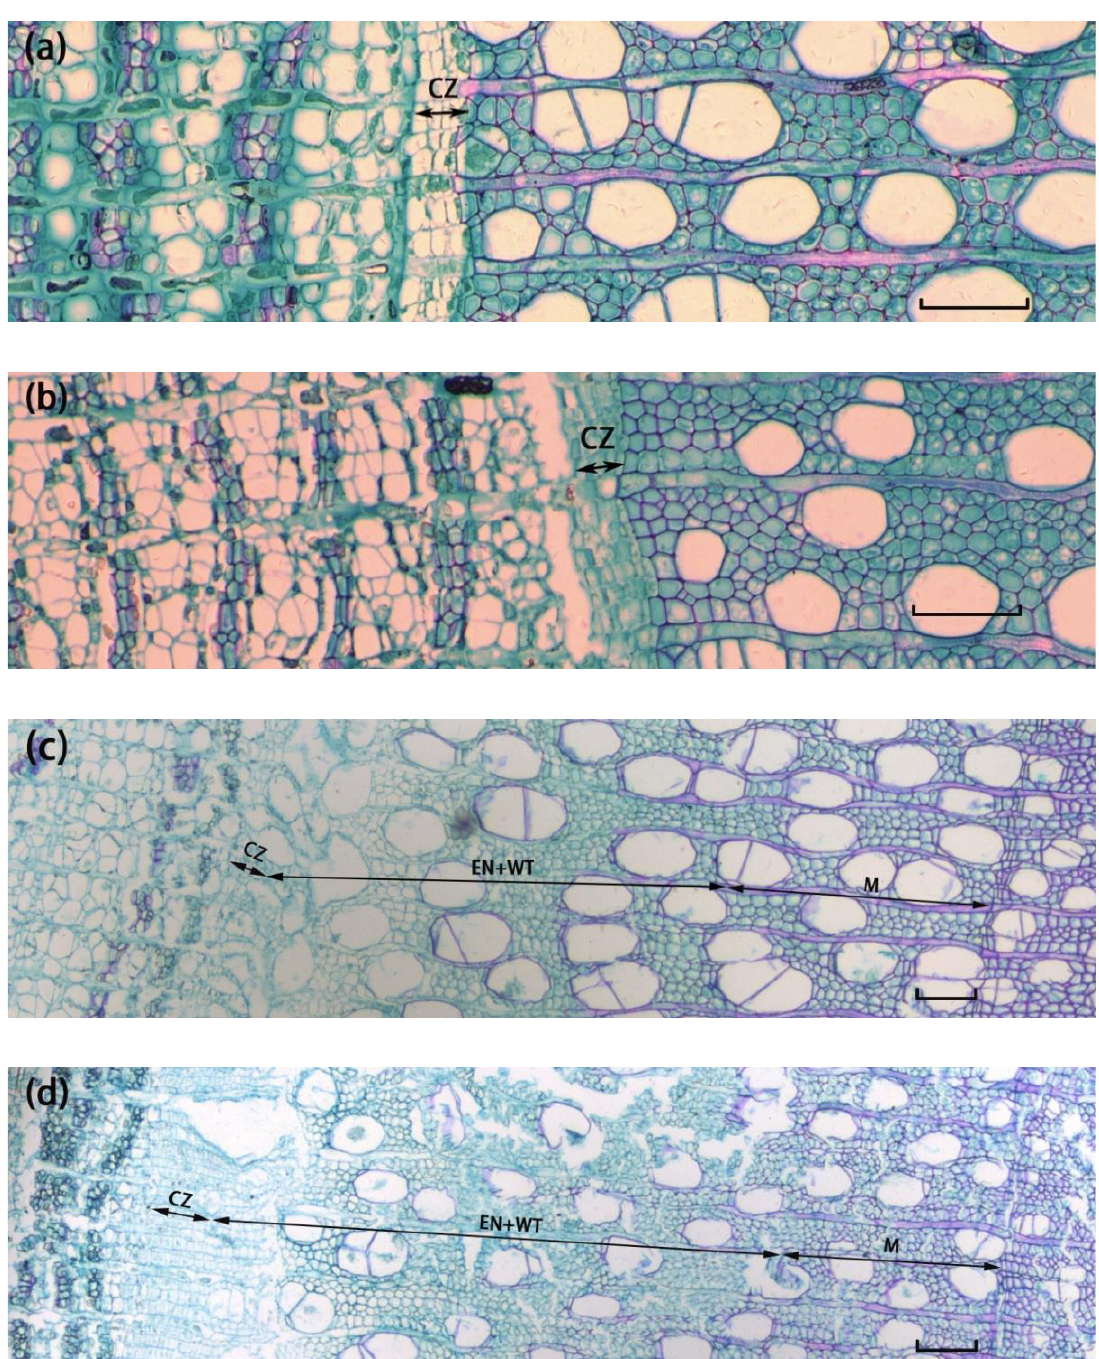
Figure 2. Phases of wood formation of Salix babylonica ( a , c ) and Salix matsudana ( b , d ) in 2018. ( a , b ): on 10 March, no new xylem cell production was observed and the cambial zone (CZ) consisted of five to six cells and four to five cells for Salix babylonica ( a , c ) and Salix matsudana , respectively. ( c , d ): In the middle of the growing season (4 May) enlarging (EN), wall-thickening (WT), and mature (M) cells in xylem. Scale bar = 100 μm.